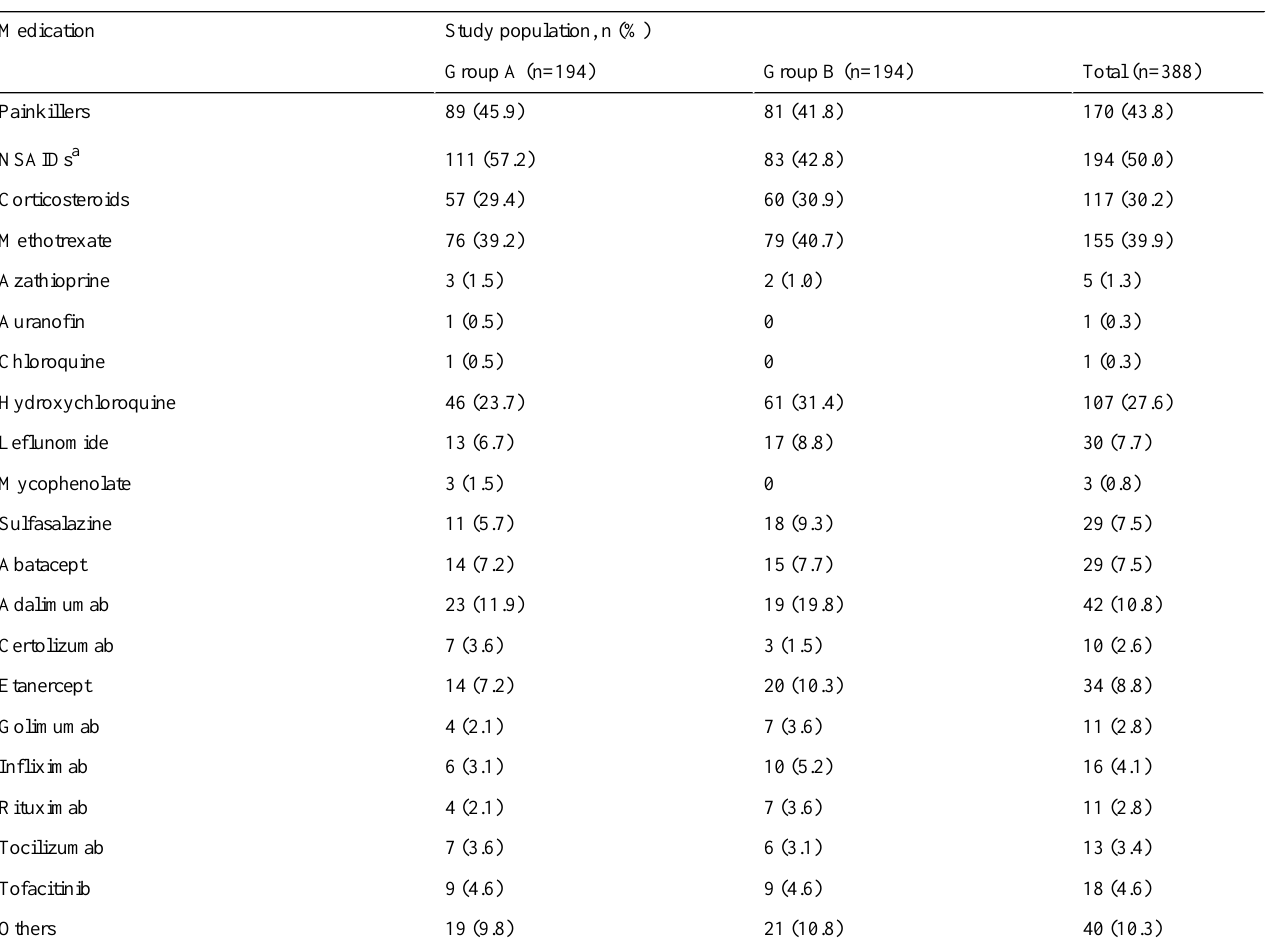
Table 2. Current rheumatoid arthritis